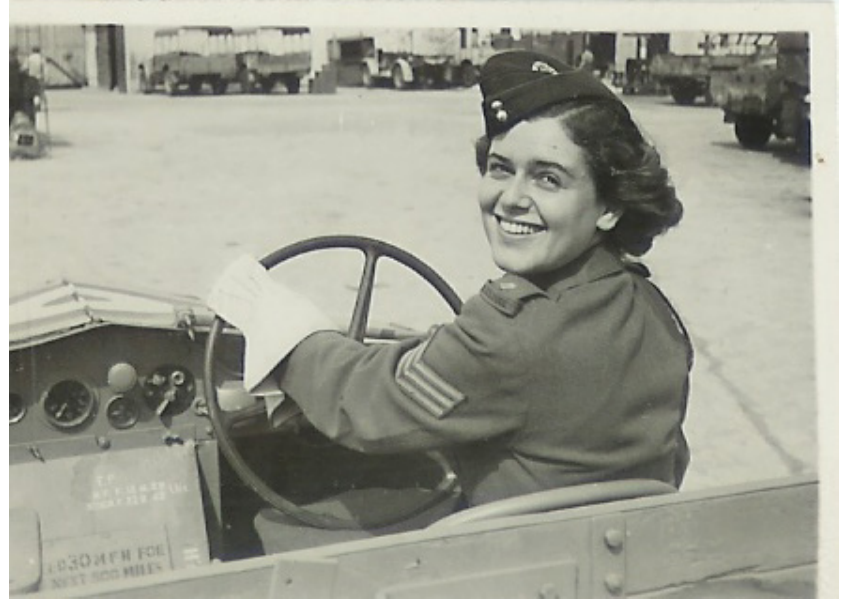
Figure 2. Leah Seidemann, ATS,